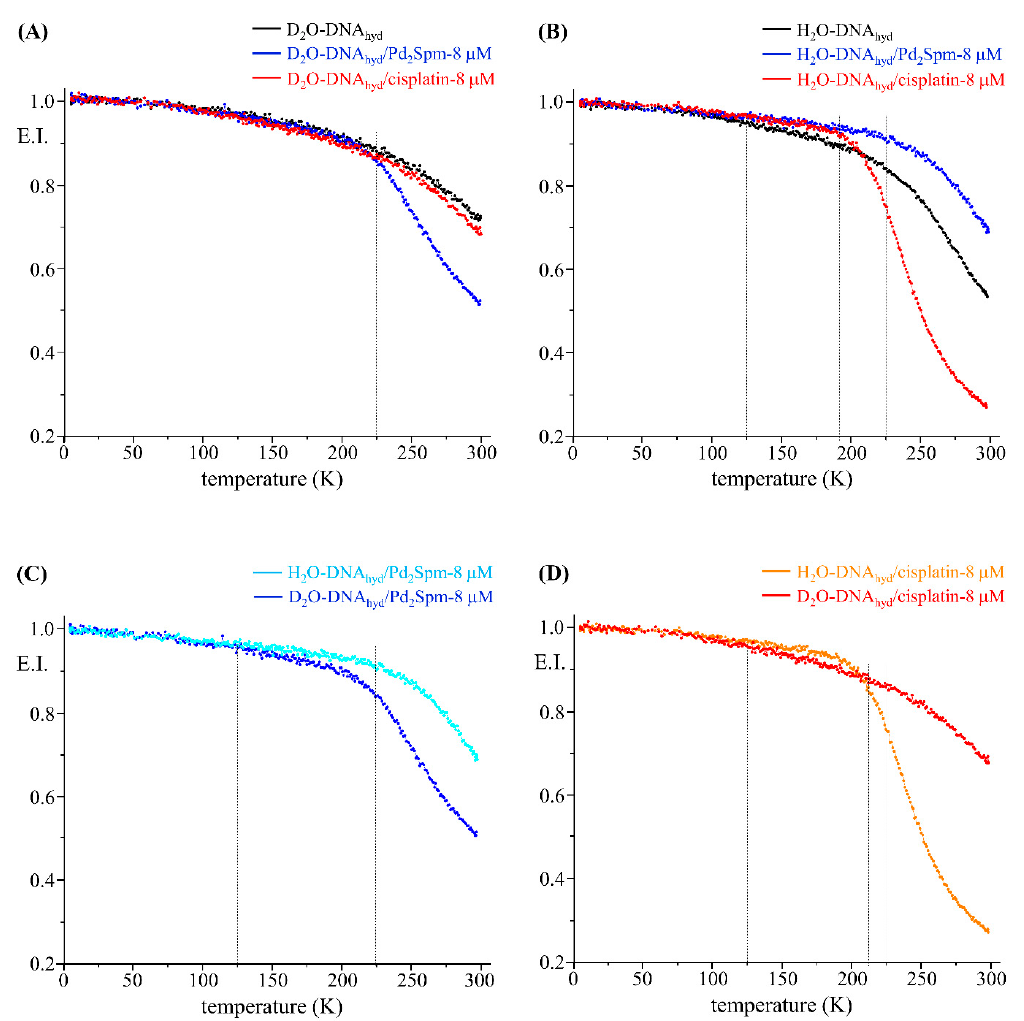
Figure 7. Elastic scan plots (5–298 K) for untreated and drug-exposed (8 μ M) D 2 O- and H 2 O-DNA hyd .